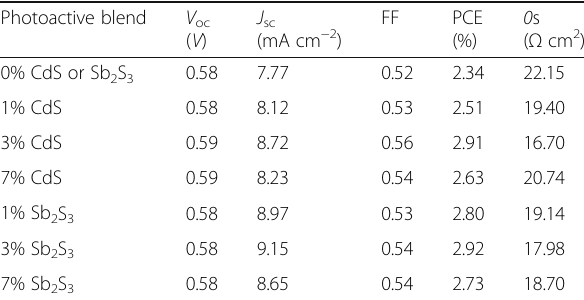
Table 1 Photovoltaic properties of the HSCs based on P3HT:PC 61 BM: CdS or P3HT:PC 61 BM: Sb 2 S 3 with different wt.% of CdS or Sb 2 S 3 nanocrystals